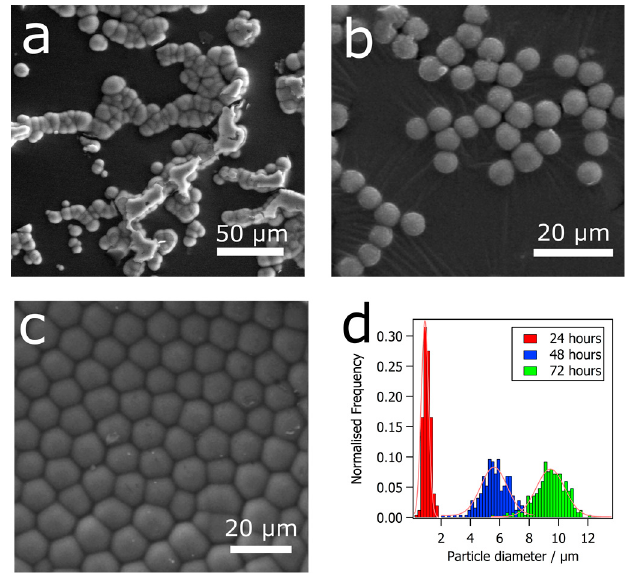
Figure 4. Growth and aggregation of spherical magnesium-calcium carbonate in the small desiccator. ( a , b ) SEM images of particles formed at the air-water interface in the small desiccator after 24 and 48 h, respectively; ( c ) Optical microscopy image of spherical particles at the air water interface after 72 h; ( d ) A histogram of particle sizes measured from optical microscopy images after 24, 48, and 72 h.